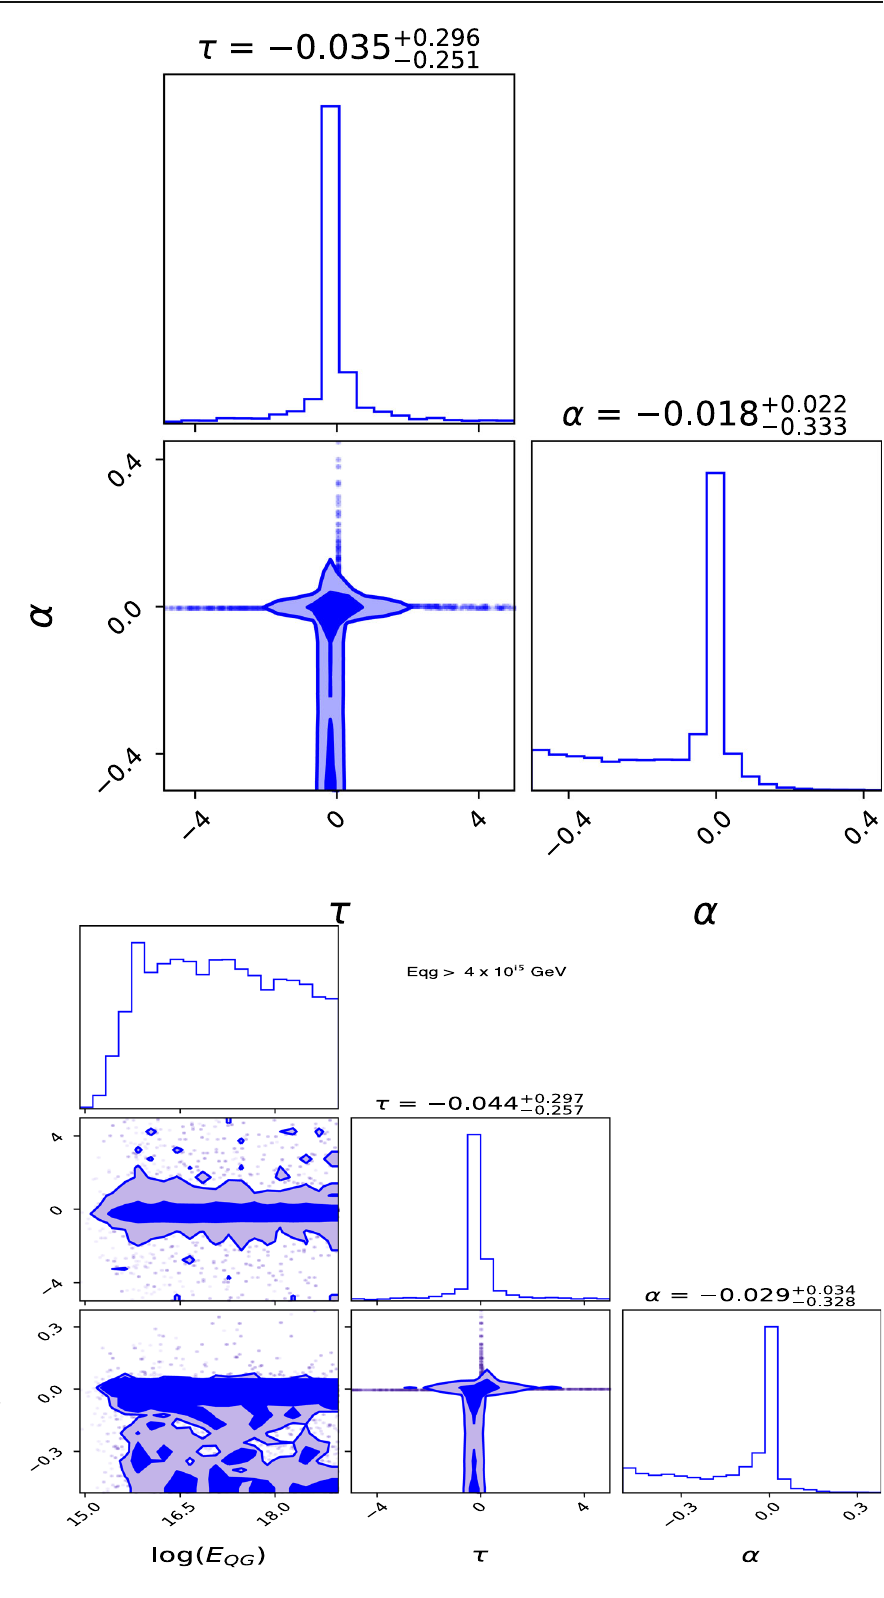
Fig. 1 The marginalized 68% and 90% credible regions for the parameters of the null hypothesis of the observed time lags being only due to intrinsic emission. The marginalized best-fit estimates for τ and α are depicted in the figure